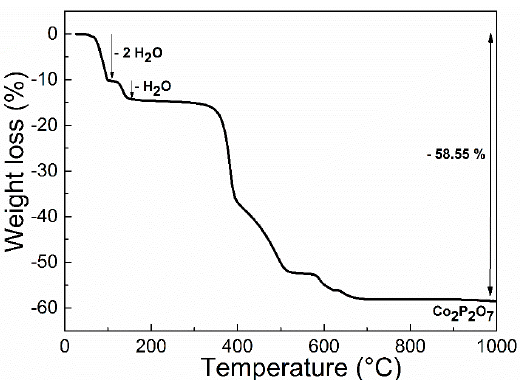
Figure 7. TGA curve of Co(H 2 O) 2 PO 3 C–C 12 H 9 ·H 2 O recorded in air from room temperature to 1000